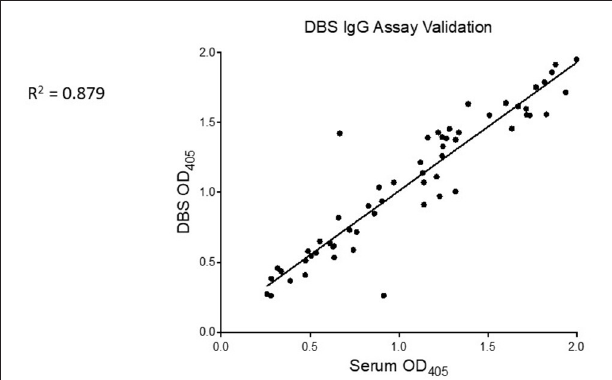
FIGURE 4 | SARS-CoV-2-specific IgG is similarly detected from serum and DBS. Serum (x-axis) and eluate from control DBS (y-axis) were run side-by-side on RBD ELISA plates. Mean OD of technical replicates was plotted on XY scatter graph in Prism and a linear regression analysis was performed. Pearson correlation coefficient and p value are displayed on